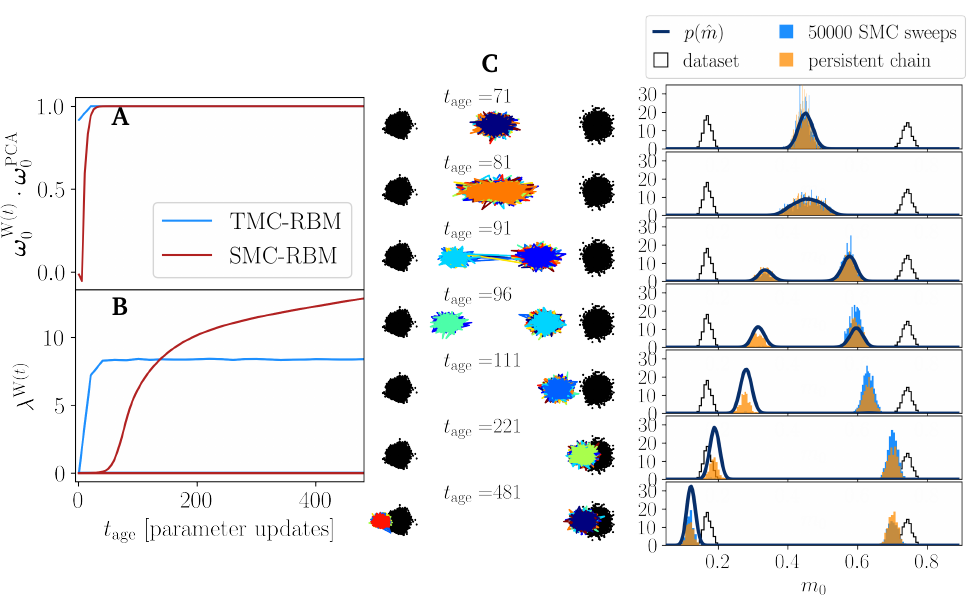
Figure 5: In A we show the projection of the first eigenvector of the RBM weight matrix W , ω W , onto the direction of the first principal component of the dataset 0 ω PCA , as a function of the number of parameter updates t , for a TMC-RBM and age 0 a SMC-RBM. In B we show the evolution of the first 10 eigenvalues of W for the two machines. Only the first eigenvalue is expressed, since only one direction is needed for this dataset: the others are almost zero. In C we examine the SMC-RBM = 71, 81, 91, 96, 111, 221, 481 updates). In at 7 different stages of training ( t age particular, in the right panel of C we compare the equilibrium distribution of m 0 obtained with the TMC method p ( ˆ m ) , the histogram of the dataset, the histogram of the persistent chain during learning, and the histogram of the samples generated with 50000 SMC sweeps. To illustrate the trapping phenomena, we show in the left − m panel of C the trajectory of several Markov chains (in the m space) obtained 0 1 during the SMC generation process (in color) and compare them with the scatter plot of the dataset projections (black